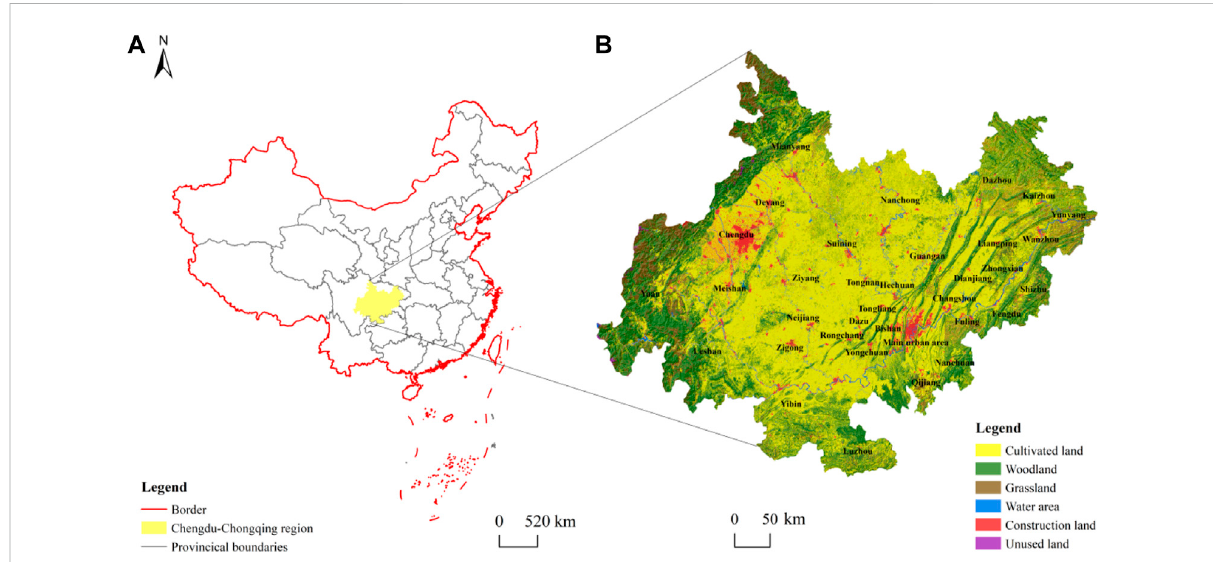
FIGURE 1 (A – B) are respective the maps of China and Chengdu-Chongqing region.